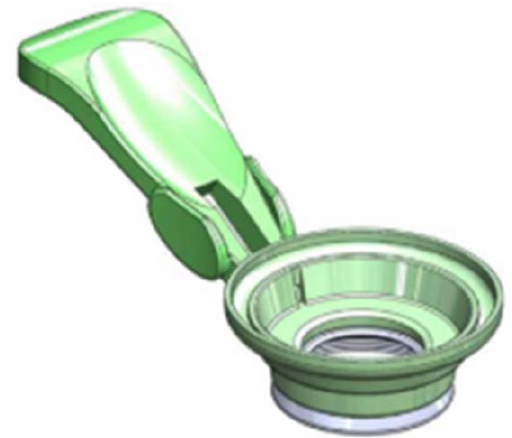
Figure 1. Schematic diagram of suction ring.